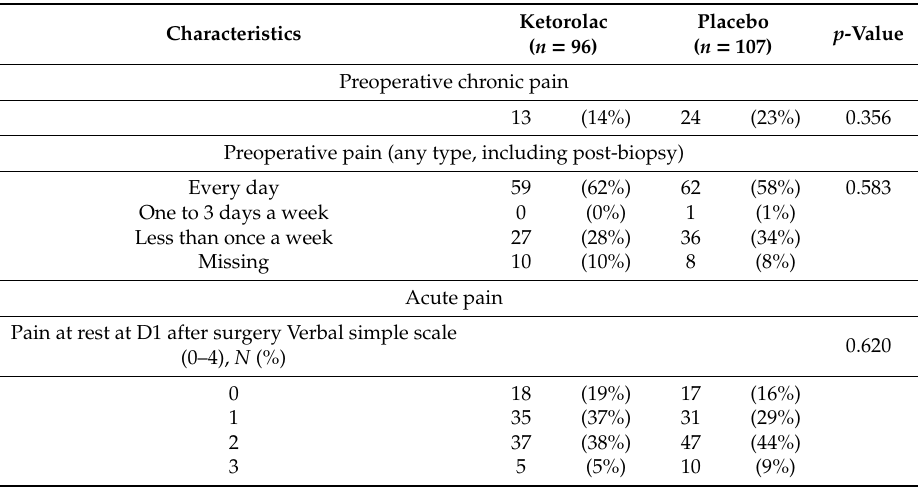
Table 2. Preoperative, acute, and persistence postoperative pain.